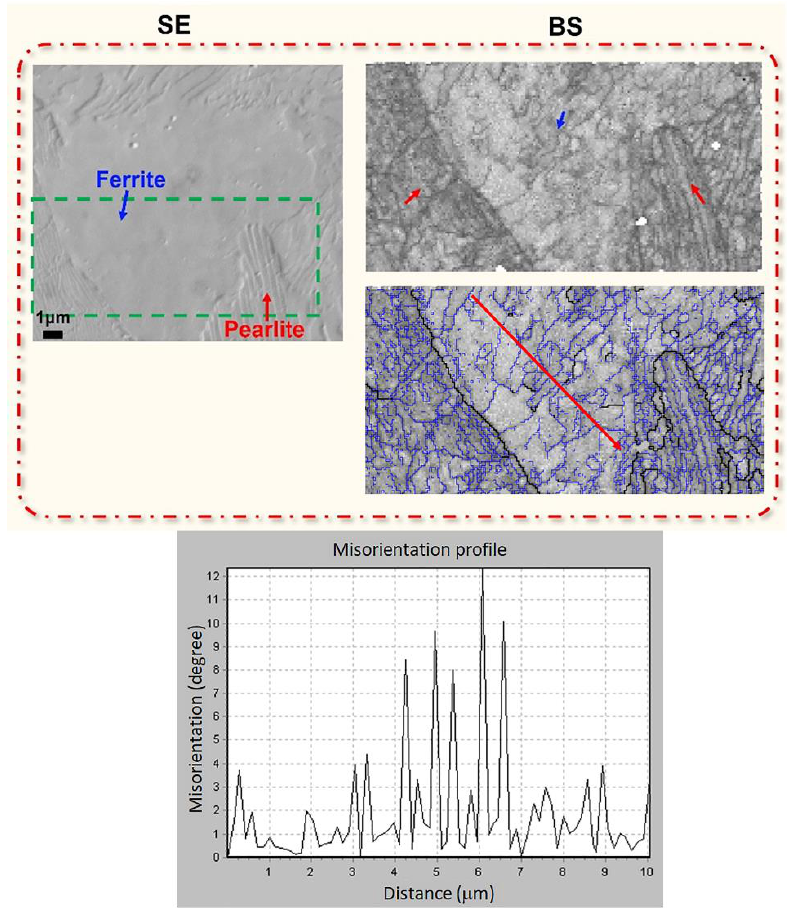
Figure 6. SE and BS maps showing the microstructure within the gauge length section of the sample fatigued at 500 MPa for 69,000 cycles. The EBSD mapping is taken from the area shown by the green dashed square area in the SE map. The blue arrows show the ferrite region, while the red arrows show pearlite areas. The two BS maps are identical, only different coloring schemes are used. The top picture uses the band slope coloring, whereas, in the lower one, black lines show dislocation boundaries with misorientation angles of θ > 15°, yellow lines show dislocation boundaries with misorientation angles in the range of 0.7° < θ < 2° and blue lines show dislocation boundaries with misorientation angles of 2° < θ < 15°. The misorientation profile between neighboring points shows misorientations of dislocation boundaries along the red arrow in the ferrite grain.